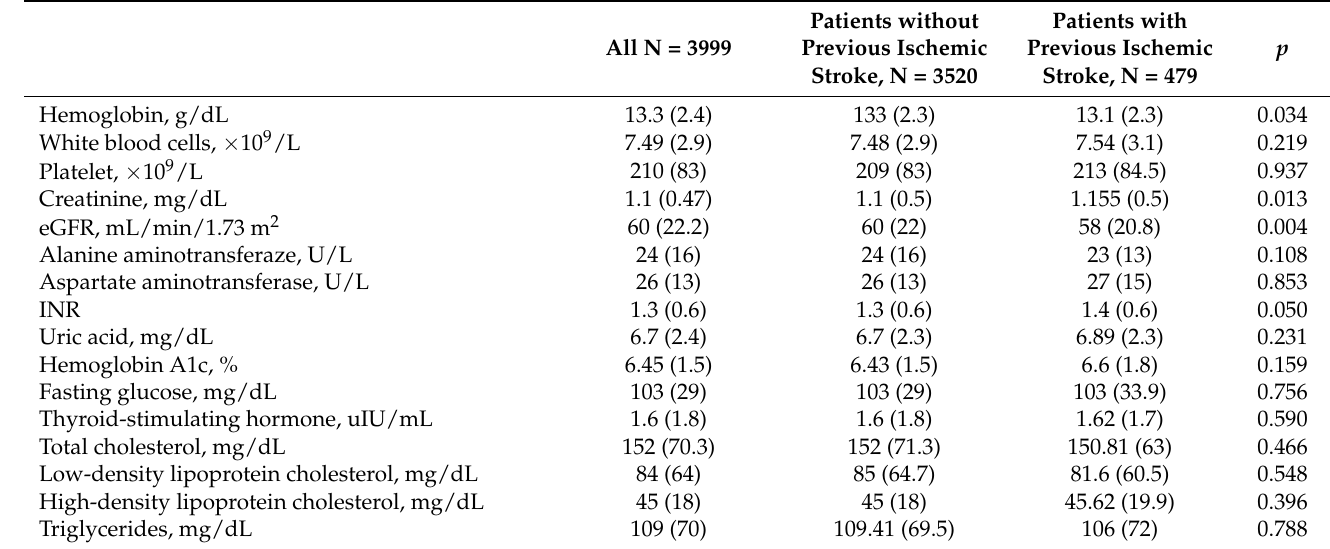
Table 4. Results of laboratory tests of patients with and without previous ischemic stroke.